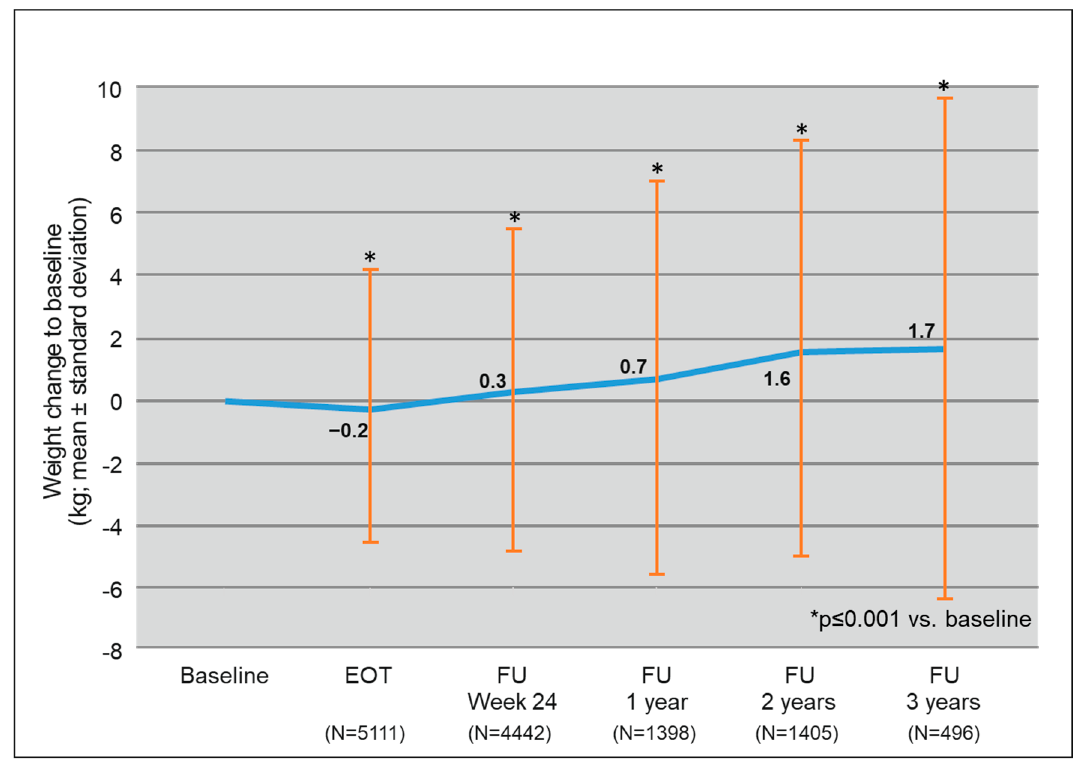
Figure 1. Increase in mean weight compared to baseline during follow-up of DAA Treatment. Abbreviations: EOT, end of treatment; FU24, follow up 12 to 24 weeks after EOT; FU1, follow up one year after EOT; FU2, follow up two years after EOT; FU3, follow up three years after EOT.